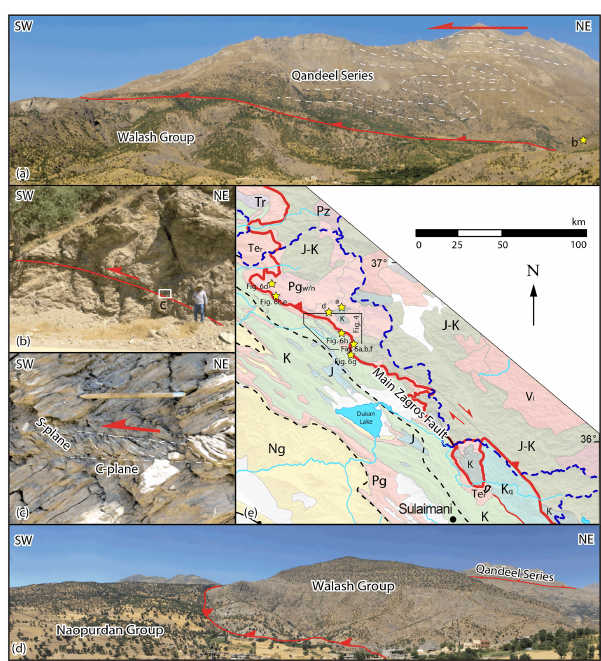
Figure 3. Landscape and outcrop photos exhibiting (a–d) the main transported thrust sheets and their interpreted direction of motion ( c , top SW sense of shear) in the NW Zagros suture zone. (e) Simplified geologic map showing field photograph locations (yellow